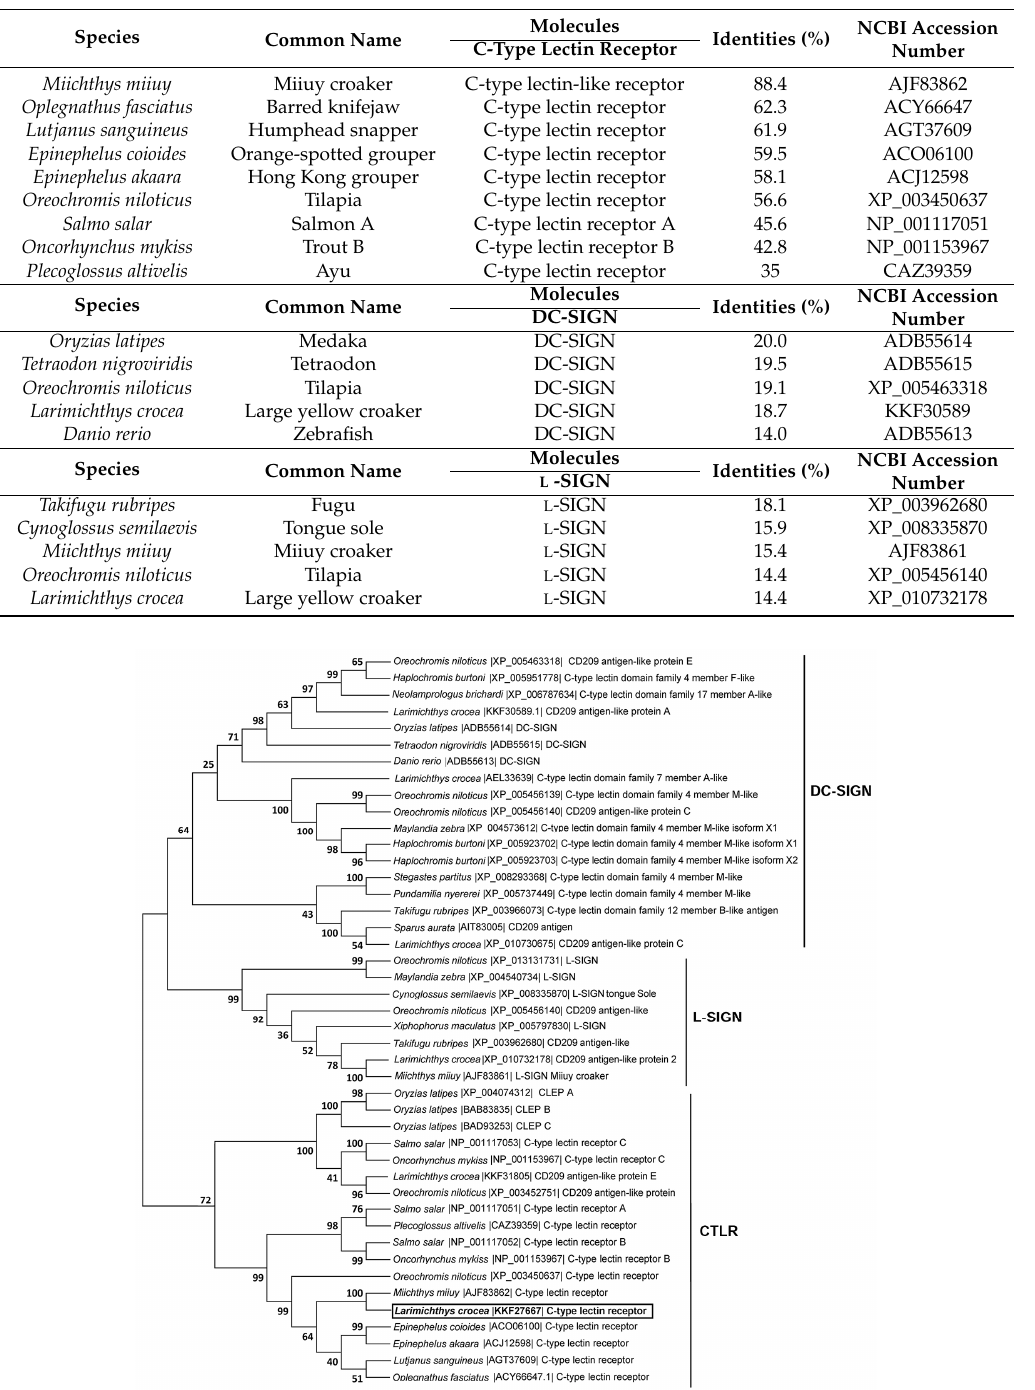
Table 1. Protein homology between LycCTLR and other C-type lectin domain-containing molecules.